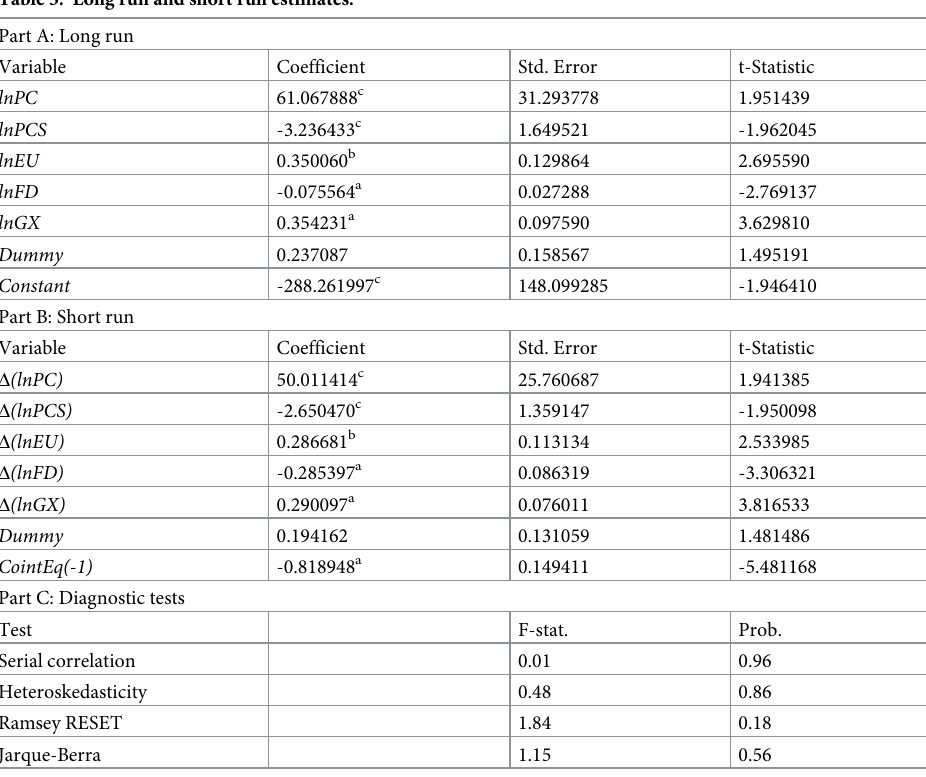
Table 3. Long run and short run